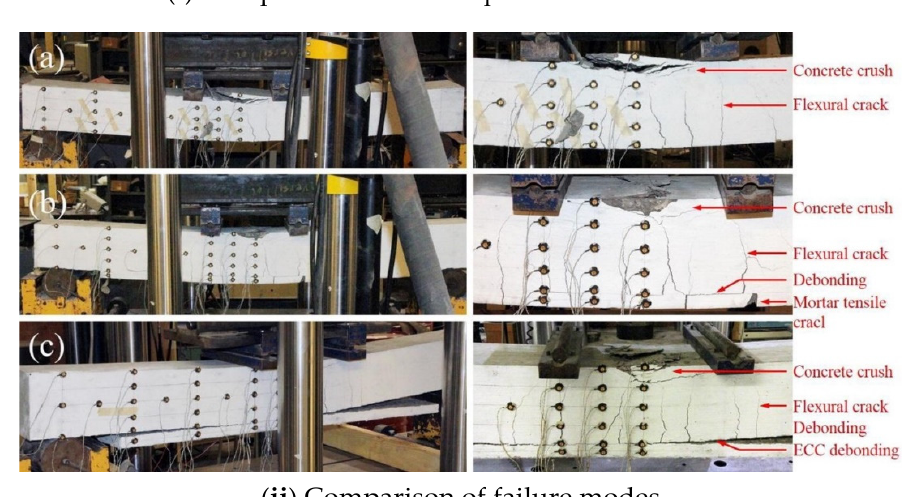
Figure 19. Comparison of strengthening efficiency with different FRP techniques. Reproduced with permission from [51], Elsevier, 2017. Note: ( a ) reference beam, ( b ) beam with CFRP mortar hybrid strengthening, ( c ) beam with CFRP-ECC hybrid strengthening.